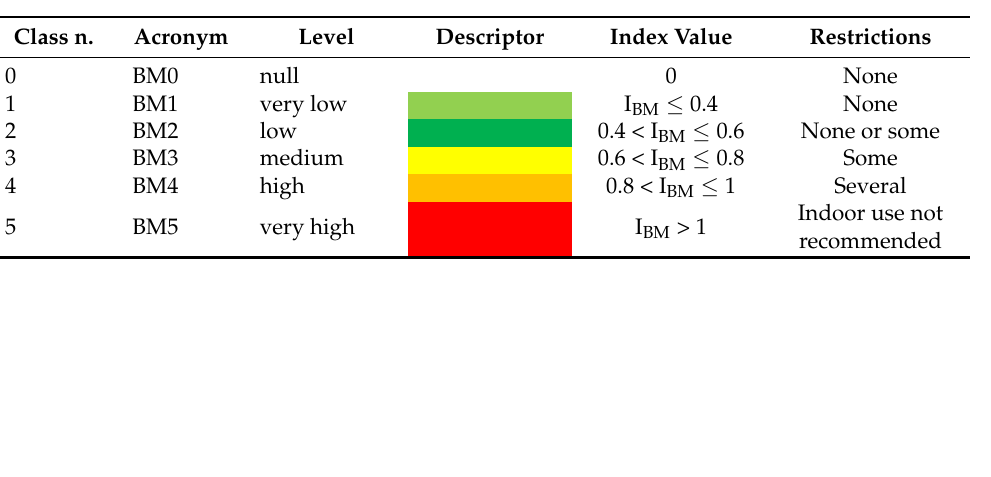
Table 5. BM index classes with indication of the acronym, level, descriptor by color, index value and required restrictions for its